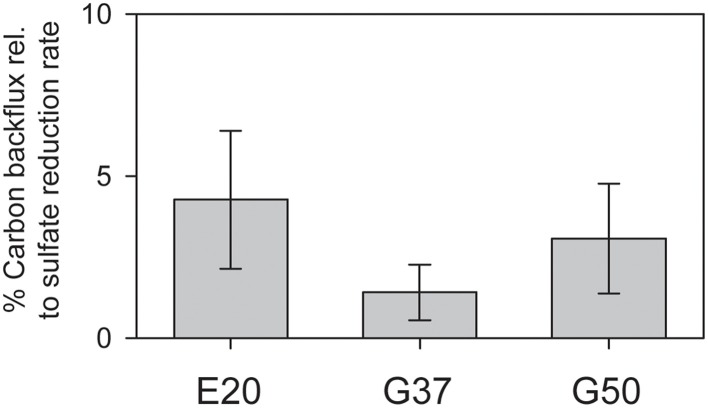
Production of 14C-methane from 14C-bicarbonate relative to AOM rates (here determined by production of 35S-sulfide from 35S-sulfate) in the three studied AOM enrichments incubated under AOM conditions at their respective temperature optima (error bars = standard deviation n = 5 per treatment).